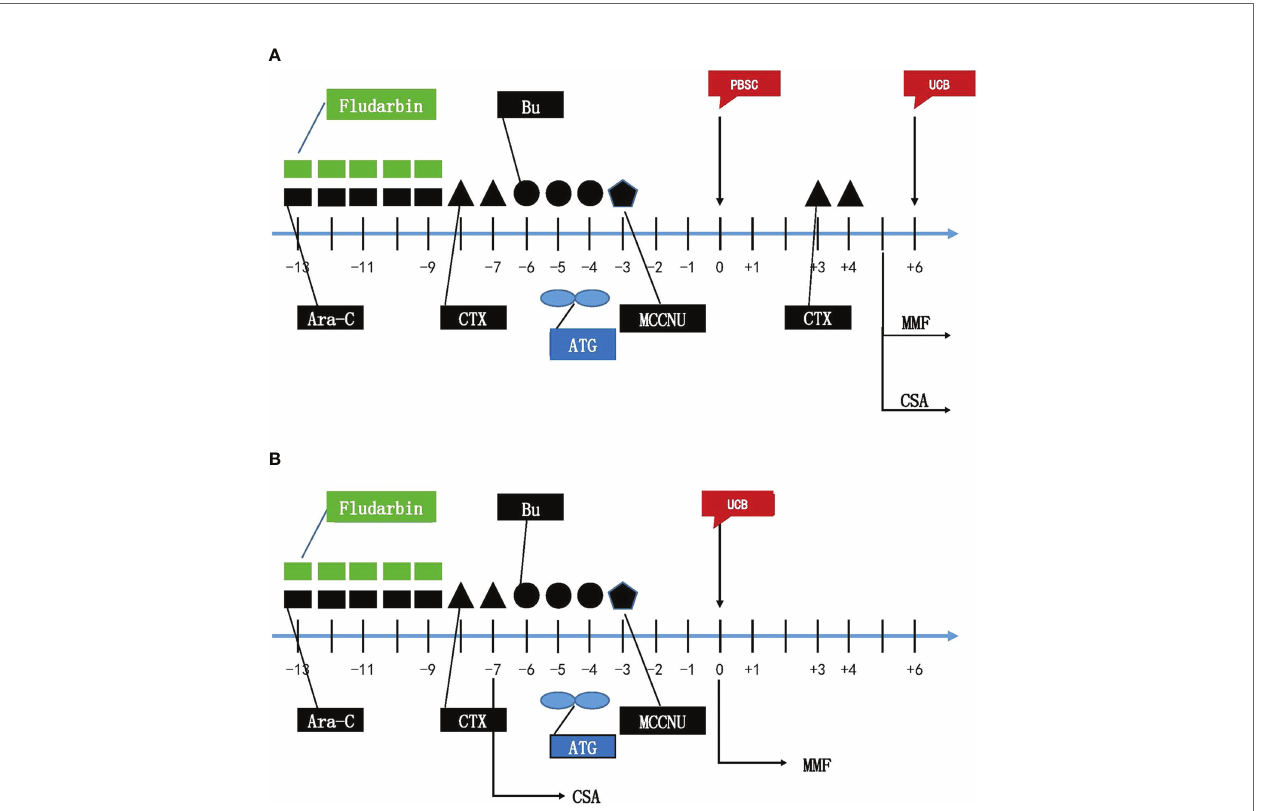
FIGURE 2 | Myeloablative Conditioning Regimens for haplo-cord HSCT (A) and single cord HSCT (B) . Flu, Fludarabine; Ara-C, cytarabine; CTX, Cyclophosphamide; Bu, busulfan; ATG, anti-thymocyte globulin; MMF, Mycophenolate mofetil; CsA Cyclosporin; PBSC, peripheral blood hematopoietic stem cells; UCB, umbilical cord blood stem